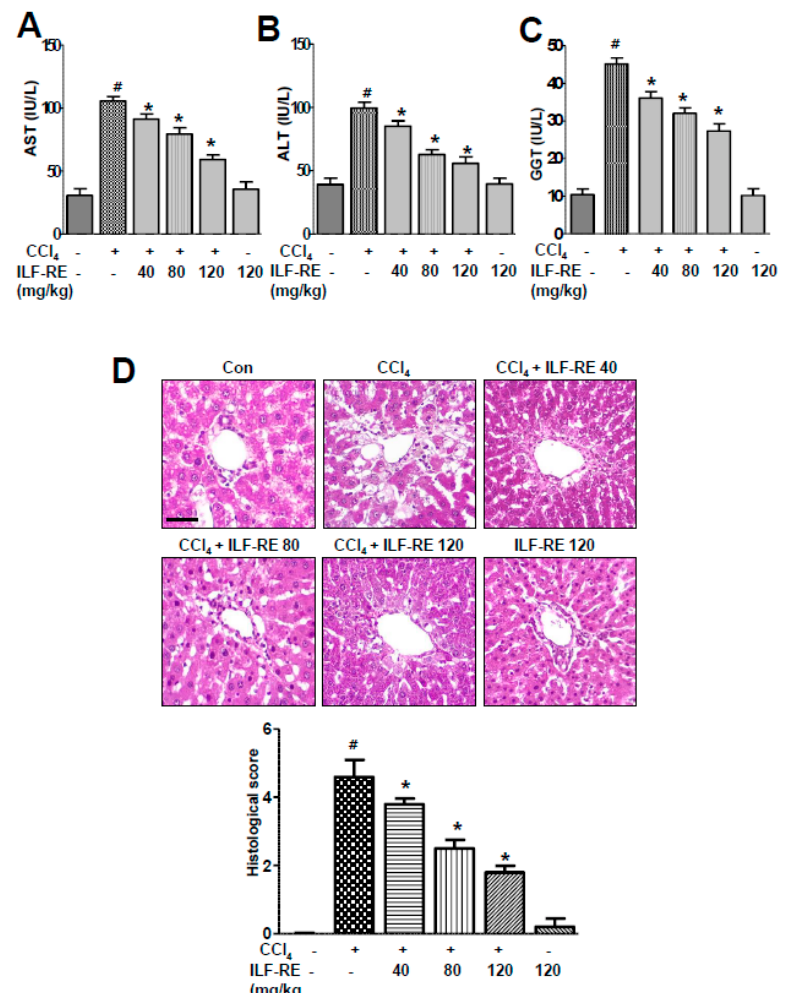
Figure 4. ILF-RE ameliorated CCl 4 -induced toxicity. Rats were intraperitoneally administered CCl 4